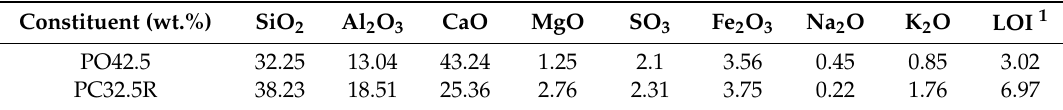
Table 1. Chemical compositions of cement.